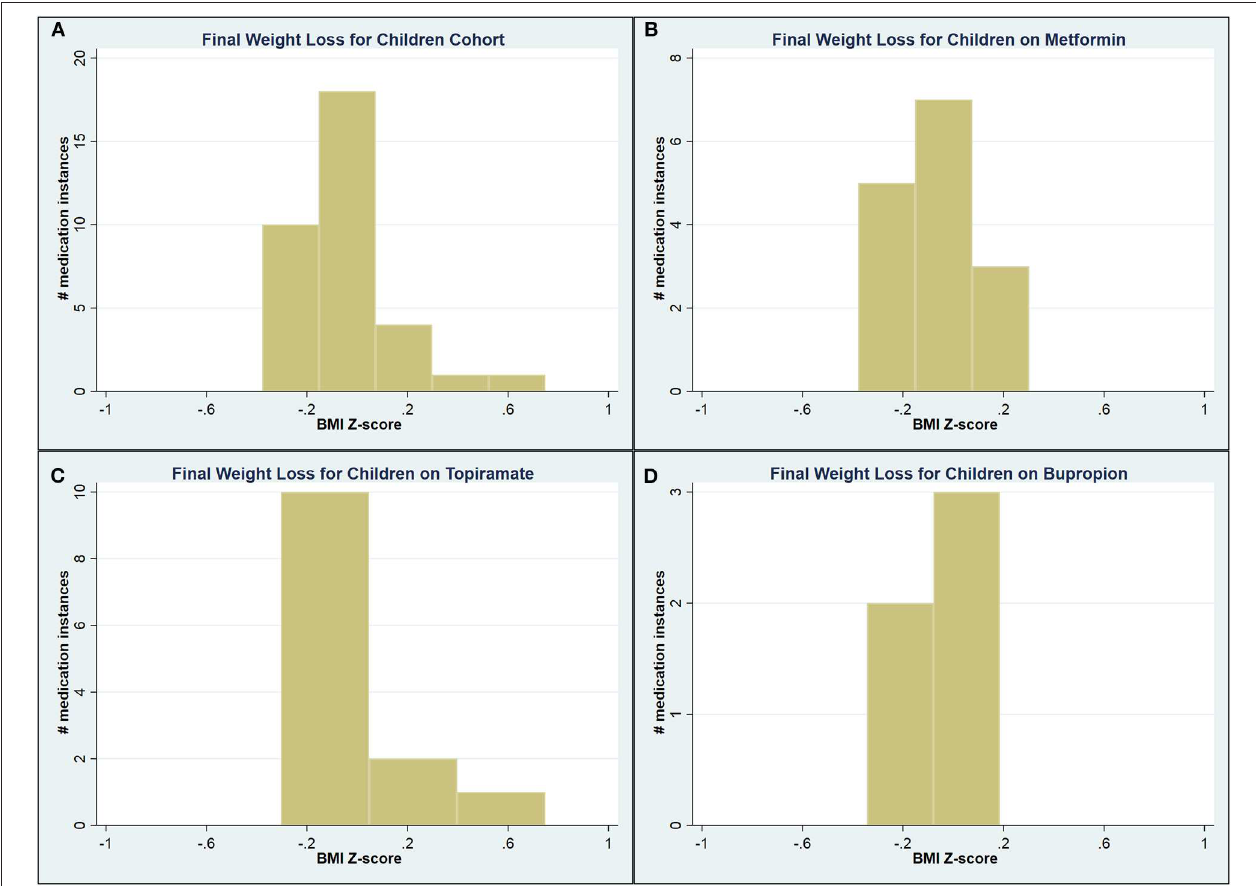
FIGURE 1 | Graphical representation of the final weight loss distribution in children cohort (A) across all medications, (B) on metformin, (C) on topiramate, and (D) on